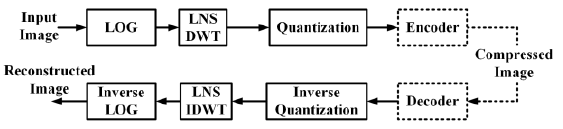
Figure 3. The proposed